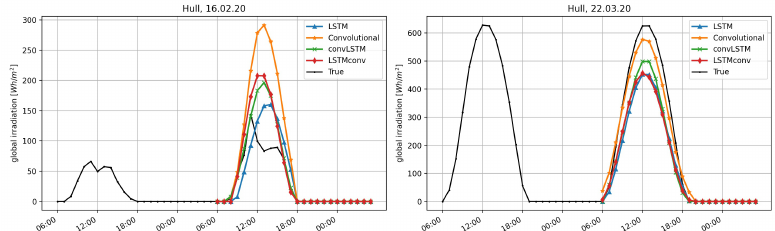
Figure 10. Global irradiation forecasts for Hull on 16 February 2020 (left) and 22 March 2020 (right).